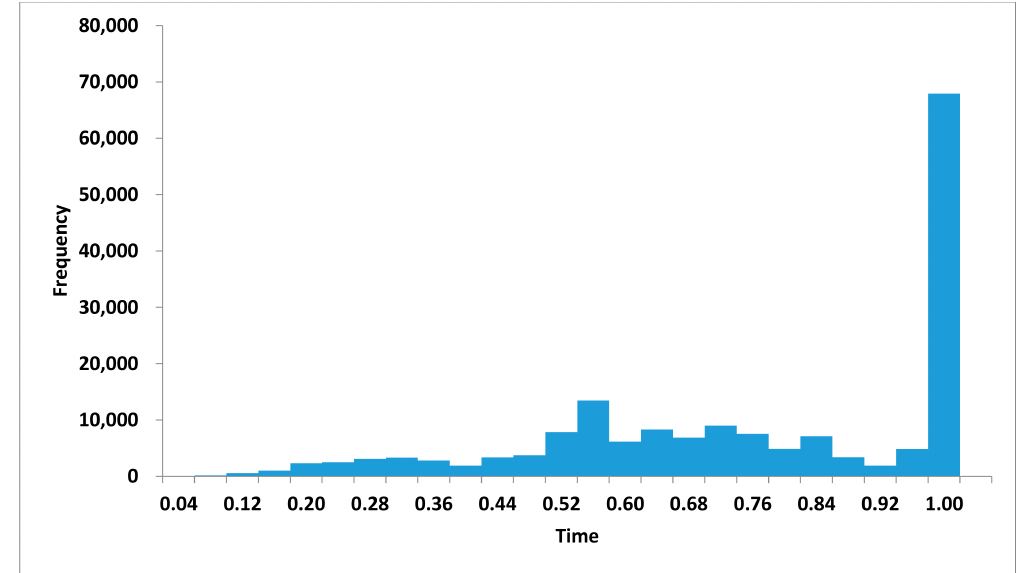
Figure 10. Exercise of the option to delay investment up to T = 1 year.